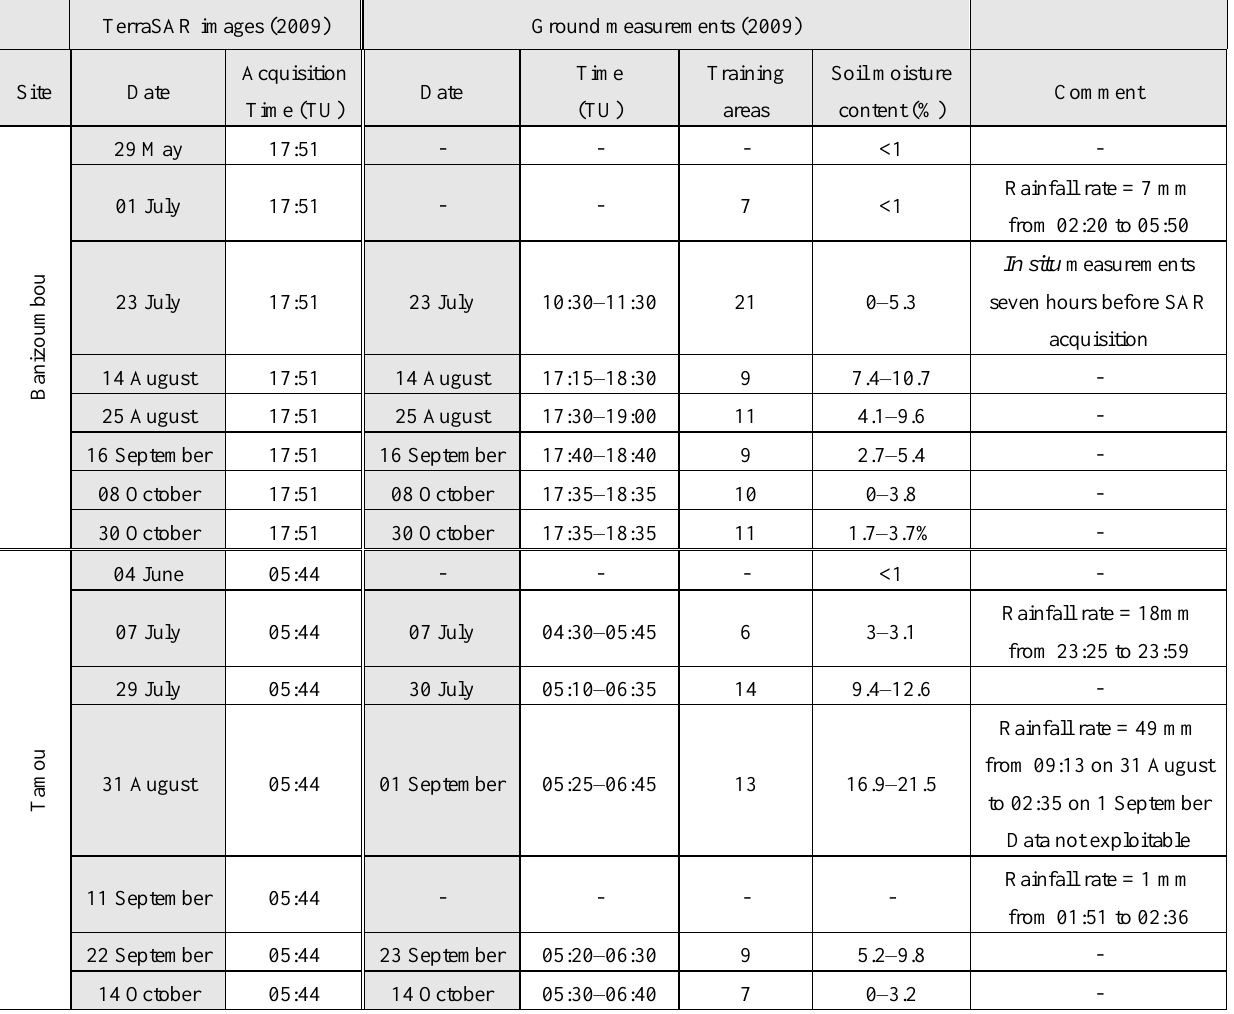
Table 2. Characteristics of in situ measurements mainly on fallows. The soil moisture content on plateaus is